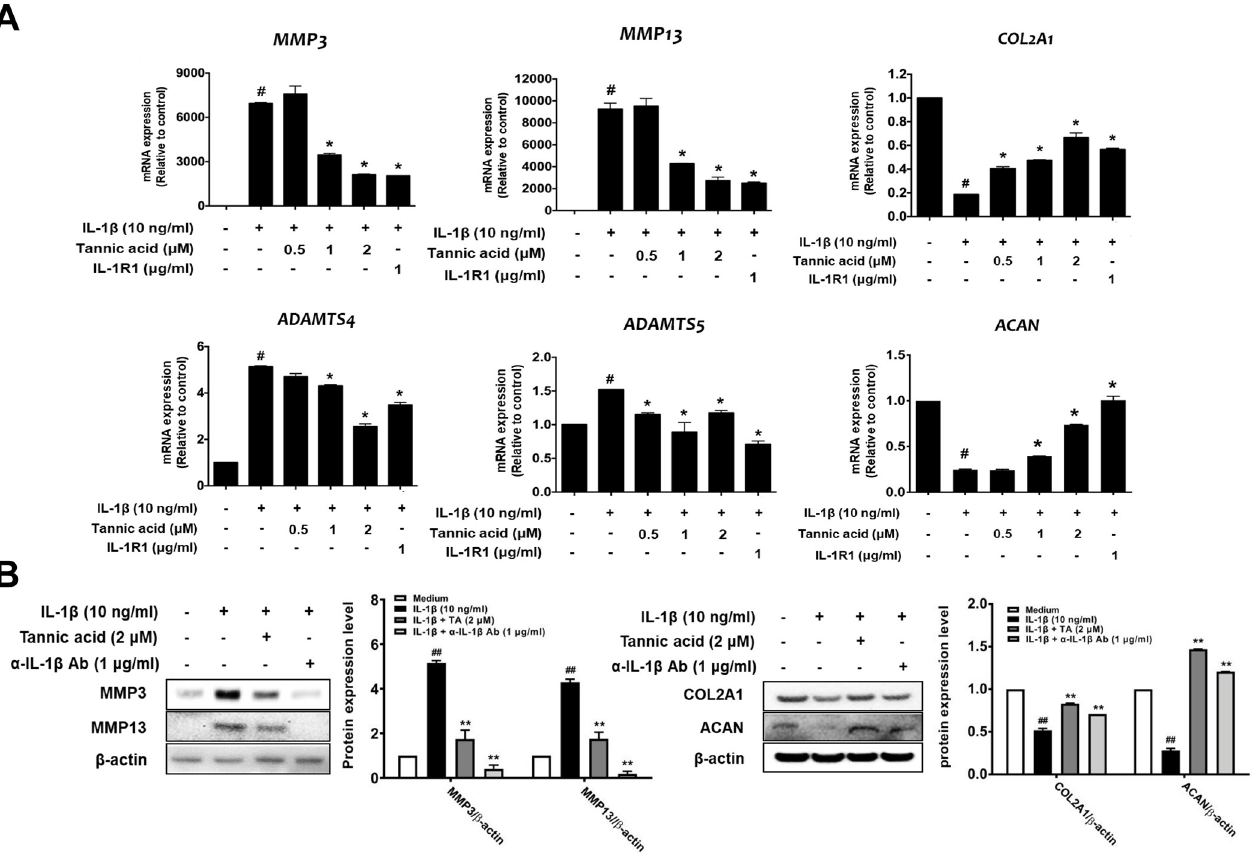
Fig 3. Effects of TA on the expression of MMPs, ADAMTSs, collagen type II and aggrecan in IL-1 β -stimulated human OA chondrocytes. Human articular chondrocytes from OA patients were seeded onto 6-well plates (3 × 10 5 cells/well) and serum-starved cells were co-treated with various concentrations of TA (2 μ M), IL-1R1 (1 μ g/ml), or anti-IL-1 neutralizing antibody (1 μ g/ml) and IL-1 β (10 ng/ml) for 48 h. mRNA and protein expressions of MMPs, ADAMTSs, collagen type II, and aggrecan were detected by qRT-PCR (A) and Western blot analysis (B). The relative quantity of each gene expression was normalized to the relative quantity of human GADPH and β -actin was used as a loading control. # p < 0.05 compared with medium only control group and * p < 0.05 compared with IL-1 β -treated group.